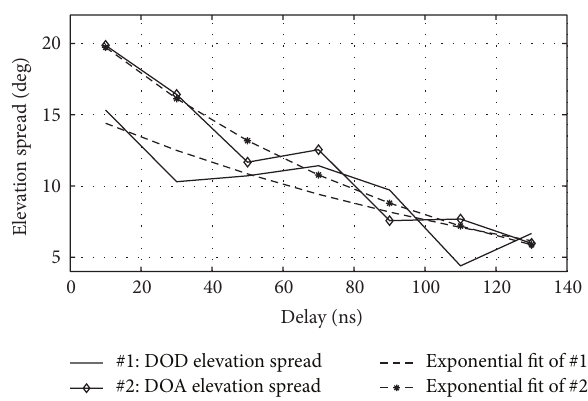
Figure 13: Empirical elevation spread as a function of delay interval 𝑇 𝑘